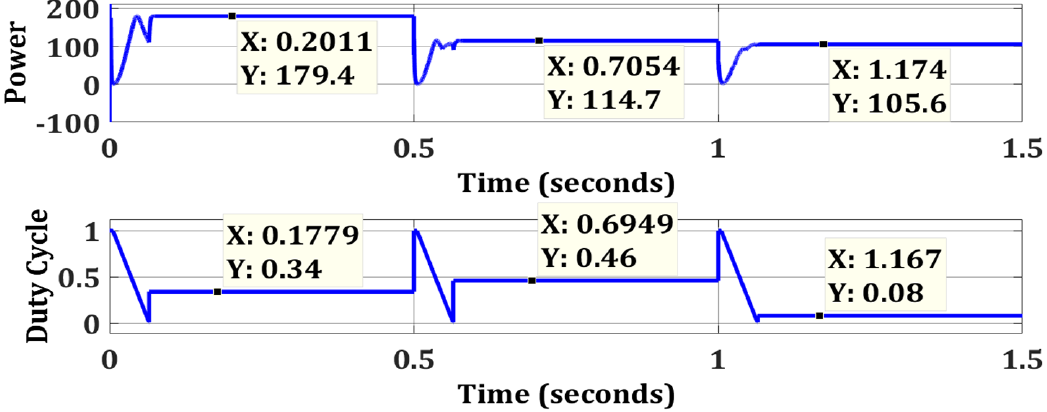
Figure 29. Changing weather conditions for 3S2P PV system configuration .